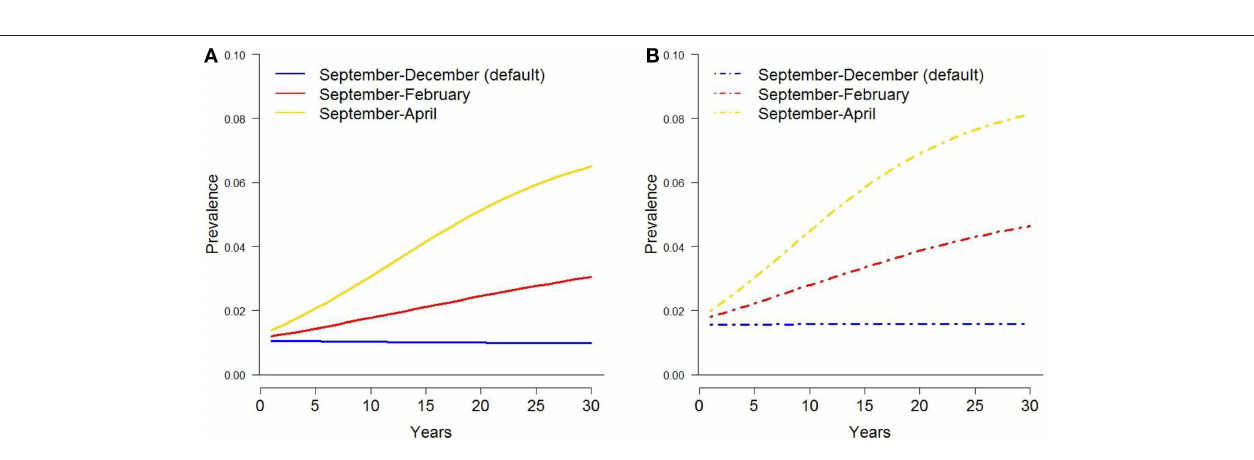
FIGURE 3 | Tuberculosis prevalence in white-tailed deer over 30 years under extended temporal availability of supplemental food piles, assuming original (A) and current (B) harvest